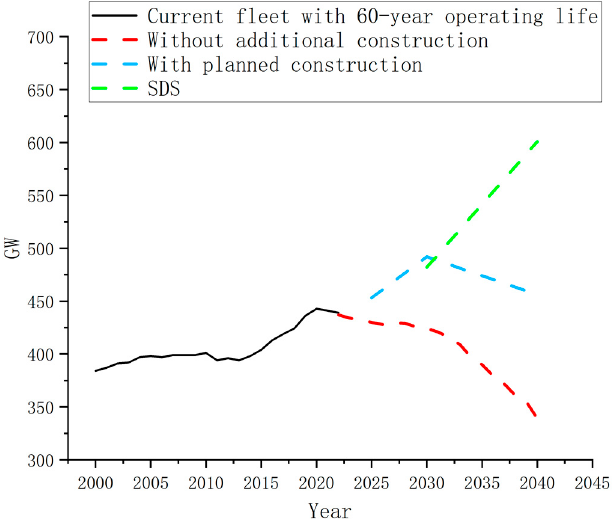
Figure 3. The total energy supply of nuclear and renewables from 1971 to 2019.